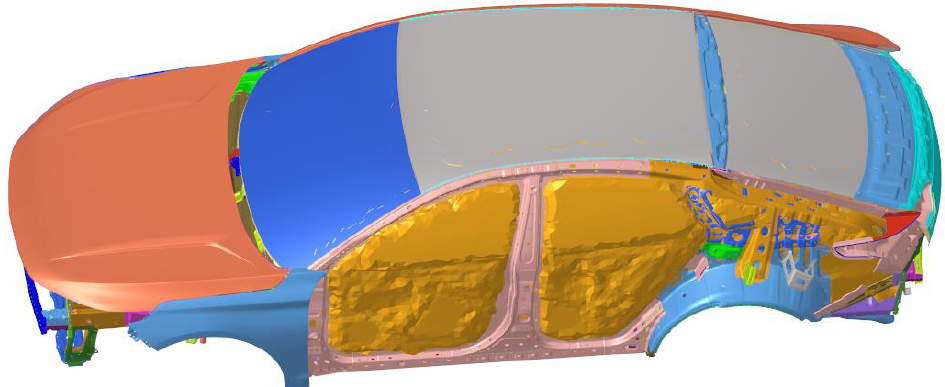
Figure 9. Sound–solid coupling finite element model of the body system.